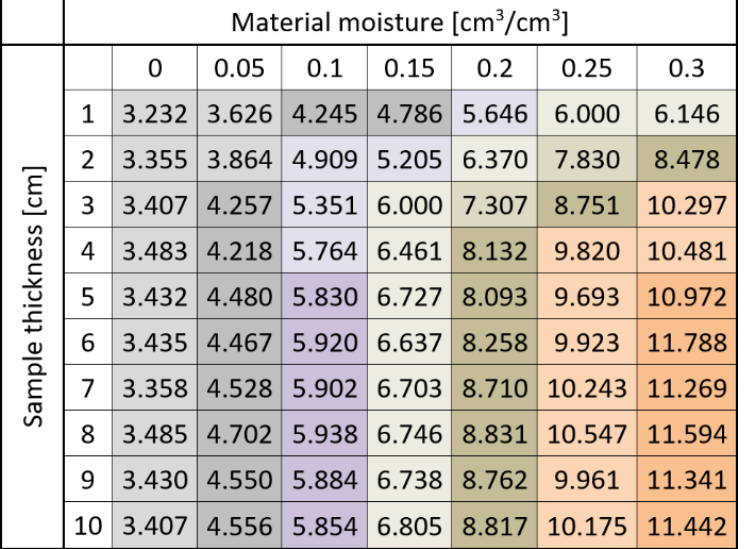
Figure 11. Post hoc analysis of apparent permittivity readouts using sensor B for various values of sample moistures and sample thicknesses. Each color means different homogenous group.